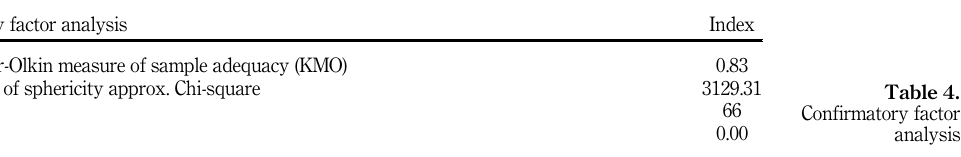
Table 3. Reliability of the health